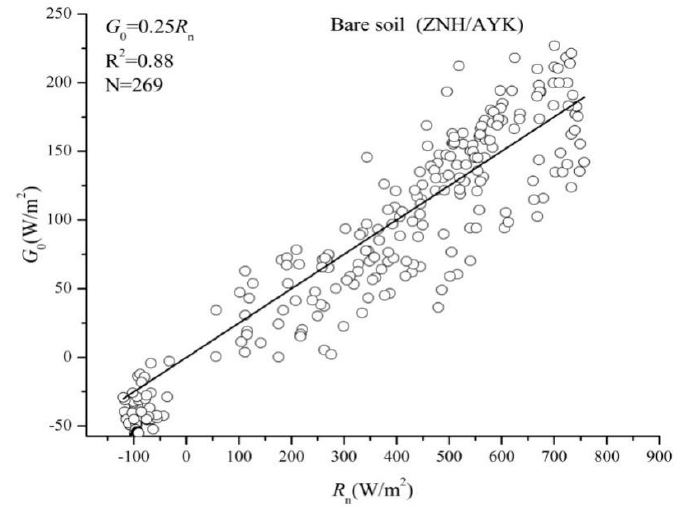
Figure A3. The ratio of G 0 / R n in bare soil estimated by the in-suit data from AYK and ZNH